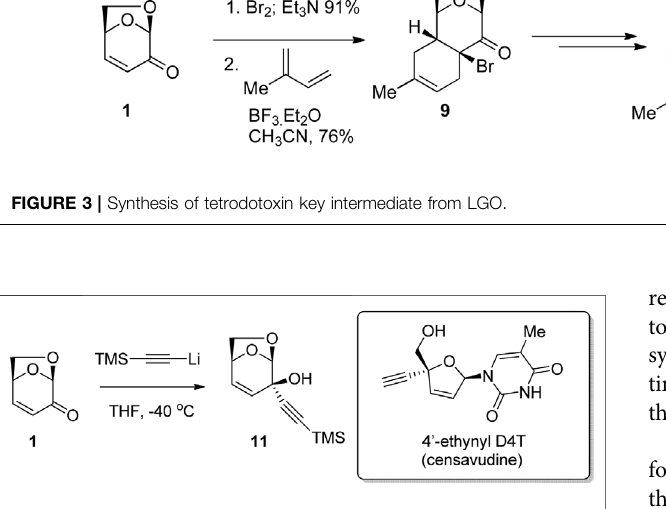
FIGURE 4 | Key synthetic step towards censavudine from LGO.